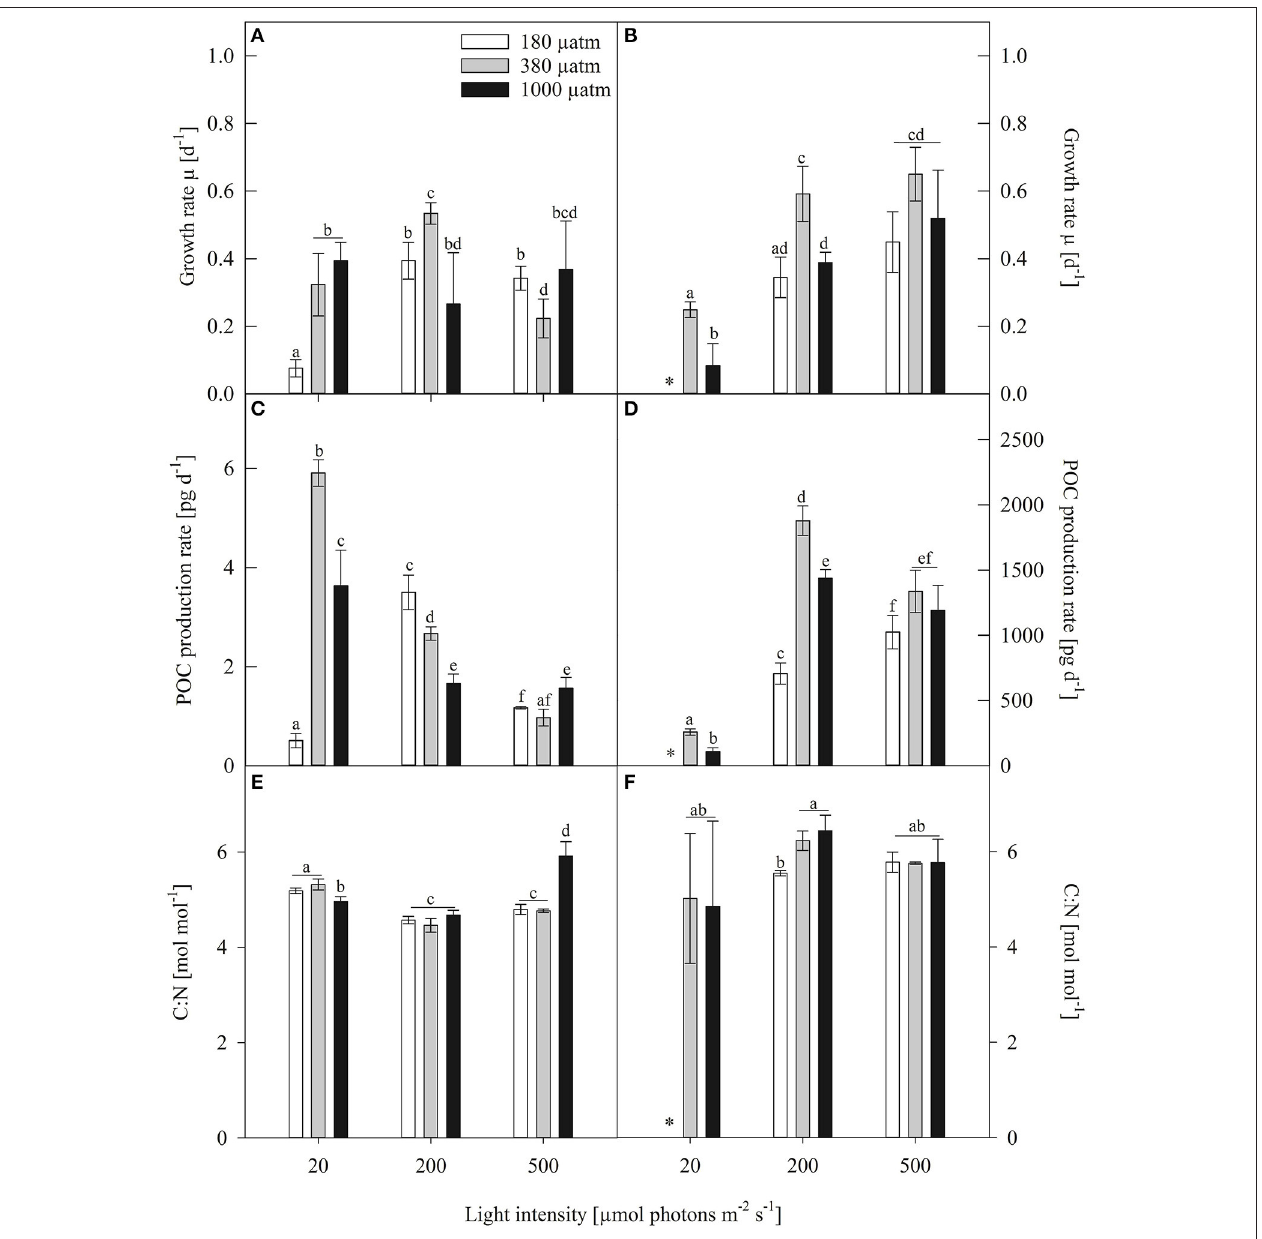
FIGURE 1 | Growth rates ( µ , d − 1 ), particulate organic carbon production (POC, pg d − 1 ) and cellular carbon to nitrogen ratio (C:N, mol mol − 1 ) of (A,C,E) Fragilariopsis and (B,D,F) Odontella acclimated to different light (LL = 20, ML = 200, HL = 500 µ mol photons m − 2 s − 1 ) and pCO 2 (low = 180, ambient = 380 and high = 1000 µ atm) conditions. Values represent mean ± SE ( n = 3). Odontella did not grow at low light in combination with low pCO 2 as indicated by *. Statistical differences between two treatments ( p = 0.05) derived from post-hoc tests are indicated by different letters.